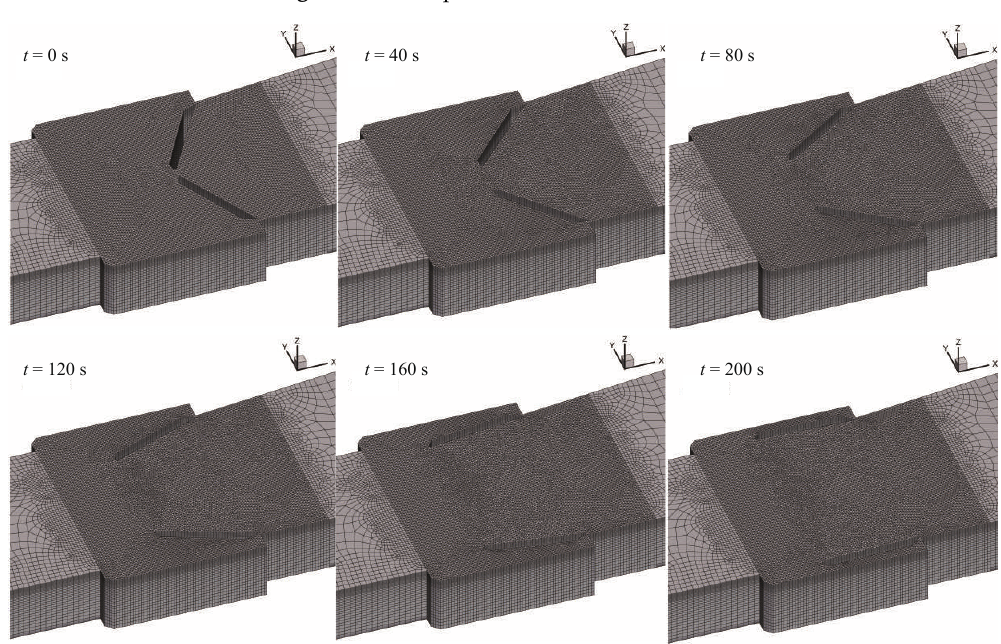
Figure 8. Mesh transformation at different